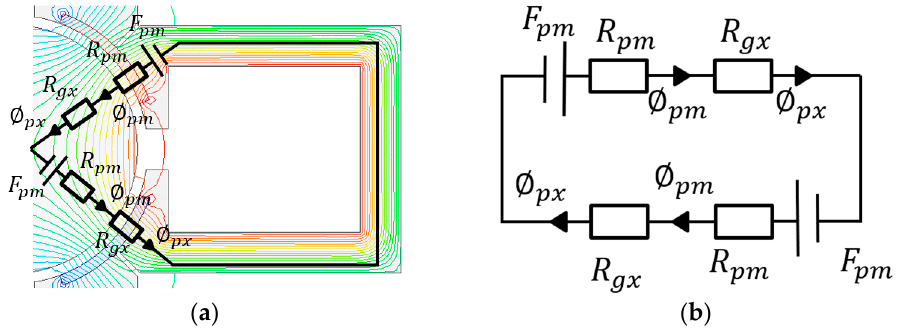
Figure 13. Magnetic equivalent circuit of bias magnetic flux of the HSTMB: ( a ) magnetic equivalent circuit and ( b ) the simplified magnetic equivalent circuit.